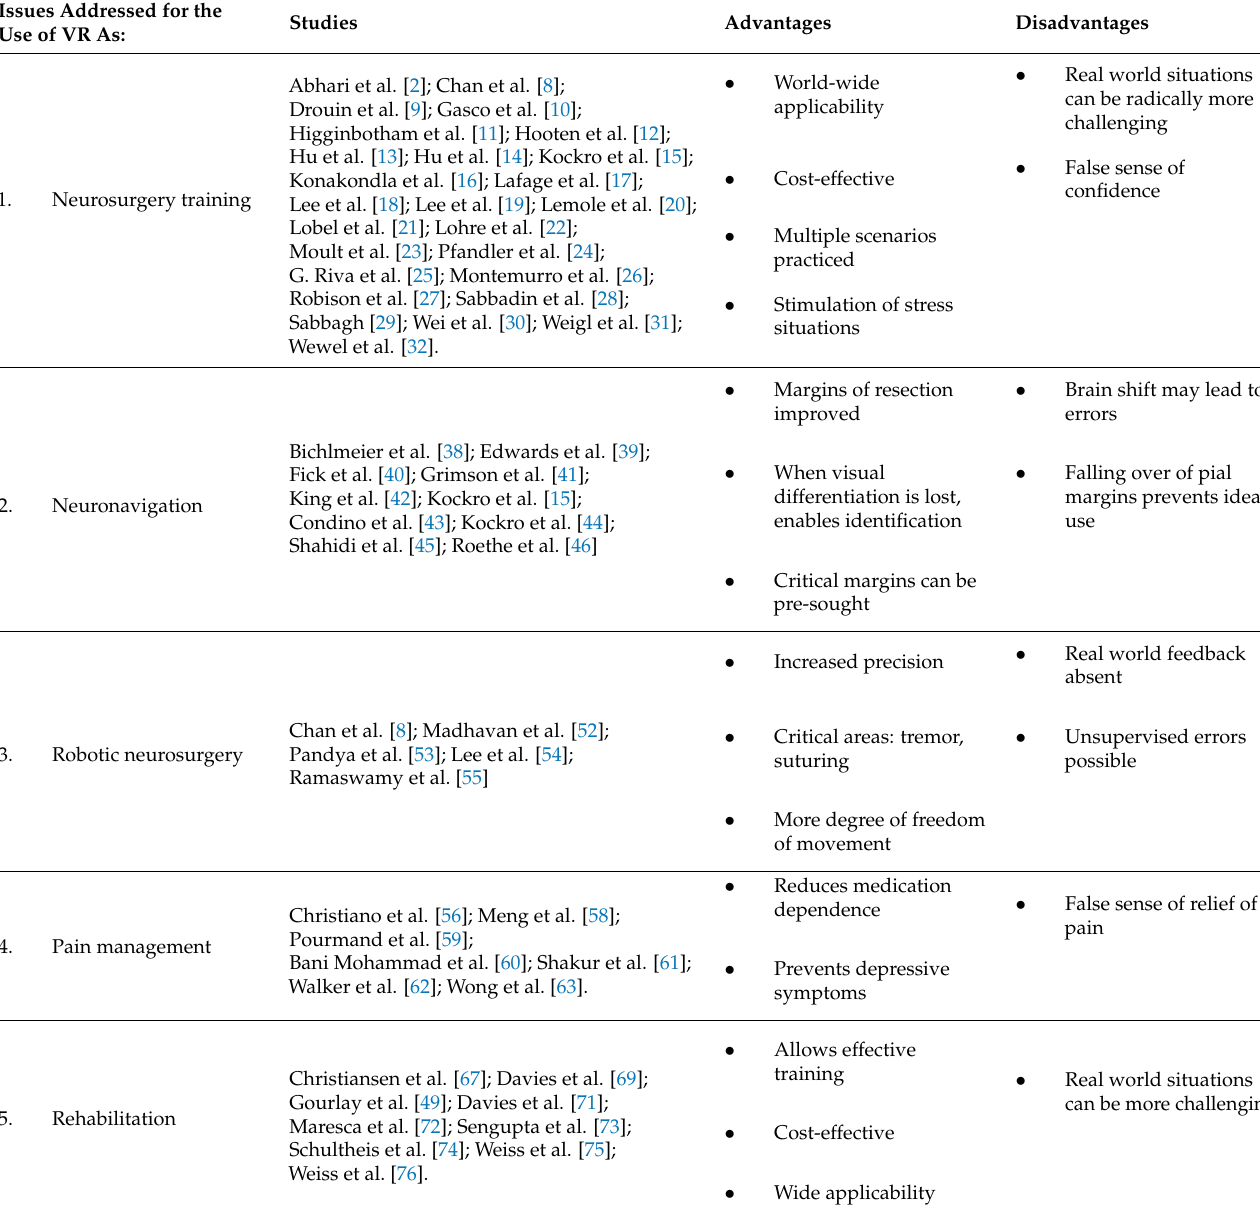
Table 1. Studies exploring the use of VR, beyond neurosurgical planning, as well as their advantages and